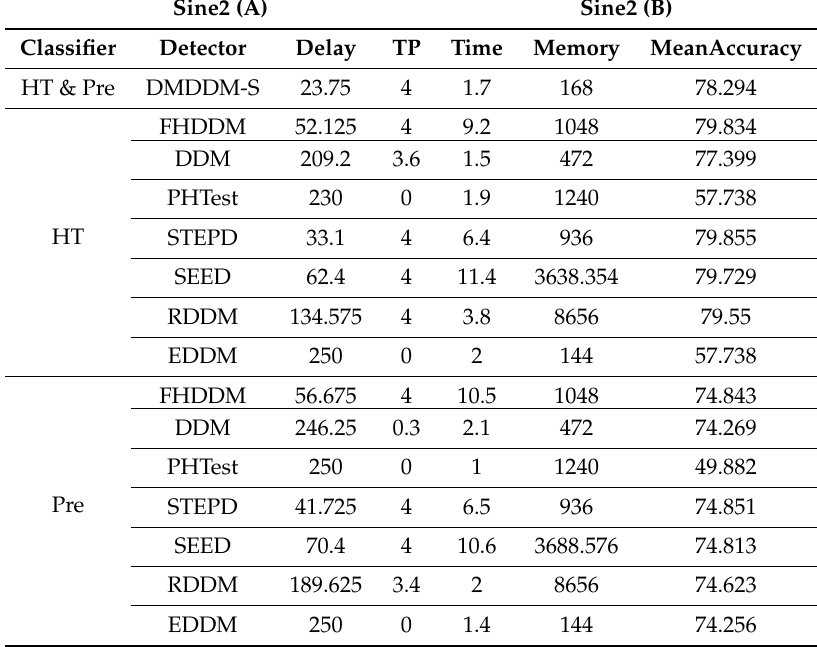
Table 3. Results of Sine2 dataset with (10% noise).